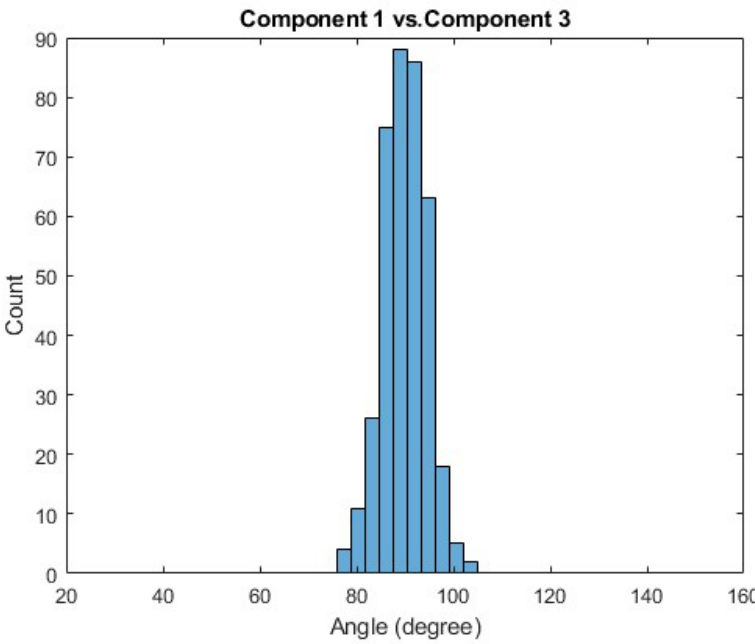
Figure A3. Histogram of the comparisons between the first principal component of some Trial A and the third principal component of some Trial B, where these comparisons are made across all trials and